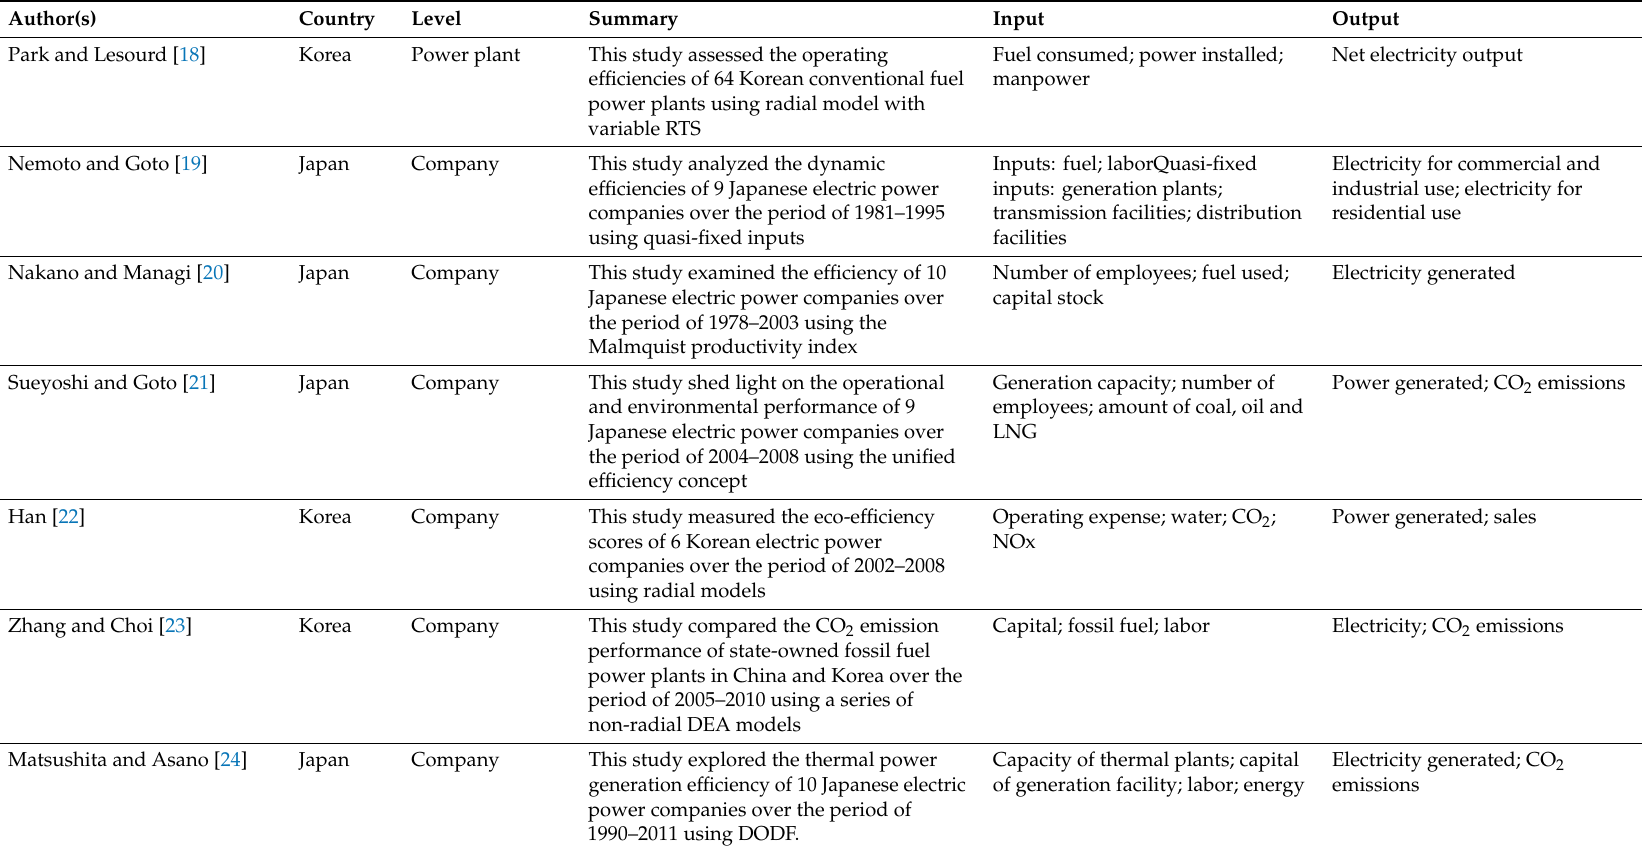
Table 1. Data Envelopment Analysis (DEA) Applications to Japanese and Korean Electric Power